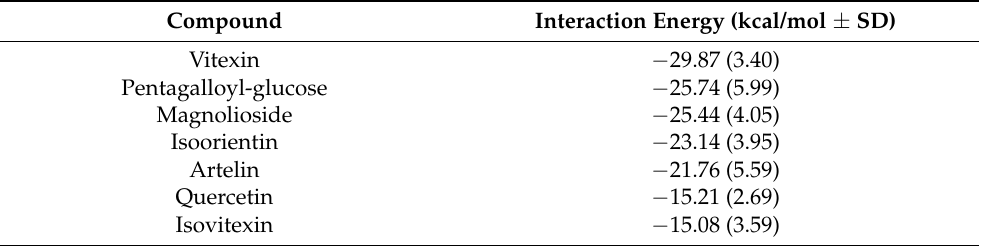
Table 4. Results of MM-GBSA analysis of the 3CLpro- PEL compounds complexes. For each com- pound, we reported the average interaction energy calculated over the last 30 ns of the